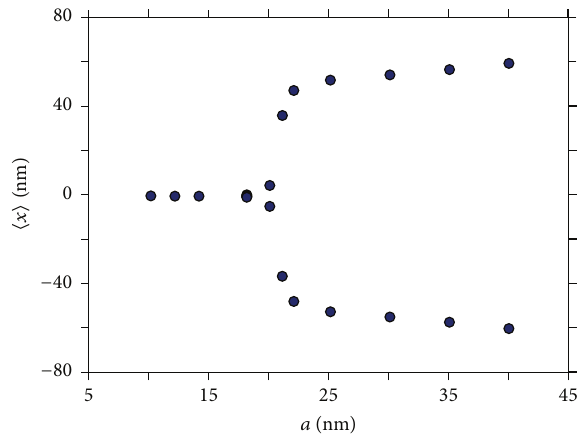
Figure 5: Average coordinate ⟨𝑥⟩ of the electron in ground state of symmetric circle shaped DQW ( 𝑅 1 = 𝑅 2 = 40 nm) as a function of the interdot distance. The numerical discretization for the used mesh leads to an energy difference Δ𝐸 ∼ 10 −7 eV of the quasidoublet ground state.